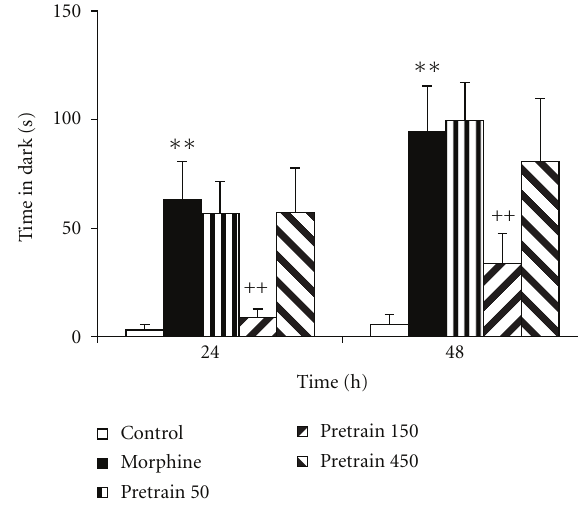
Figure 1: The e ff ects of pretraining injection of sa ff ron extract on time latency for entering the dark compartment 24 and 48h after receiving the shock in the experimental groups. The animals of control group received saline instead of both sa ff ron extract and morphine. The animals of morphine group were treated by saline instead of SE but received morphine (5mg/kg, s.c.) 30 min before the training phase. Pretrain 50, pretrain 150, and pretrain 450 groups were treated by 50, 150, and 450mg/kg of SE (i.p.), respectively, for 3 days before the training phase. The data were presented as mean ± SEM of the time latency (8 animals in each group). ∗∗ P < 0 . 01 compared with the control group; + P < 0 . 05 and ++ P < 0 . 01 compared with the morphine group.